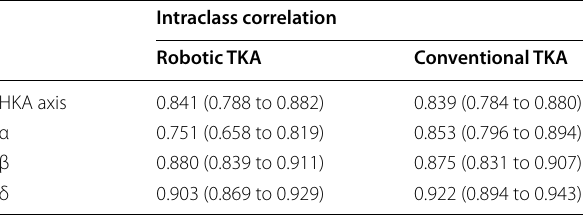
Table 3 Interclass correlation coefficient (ICC) between two observers at